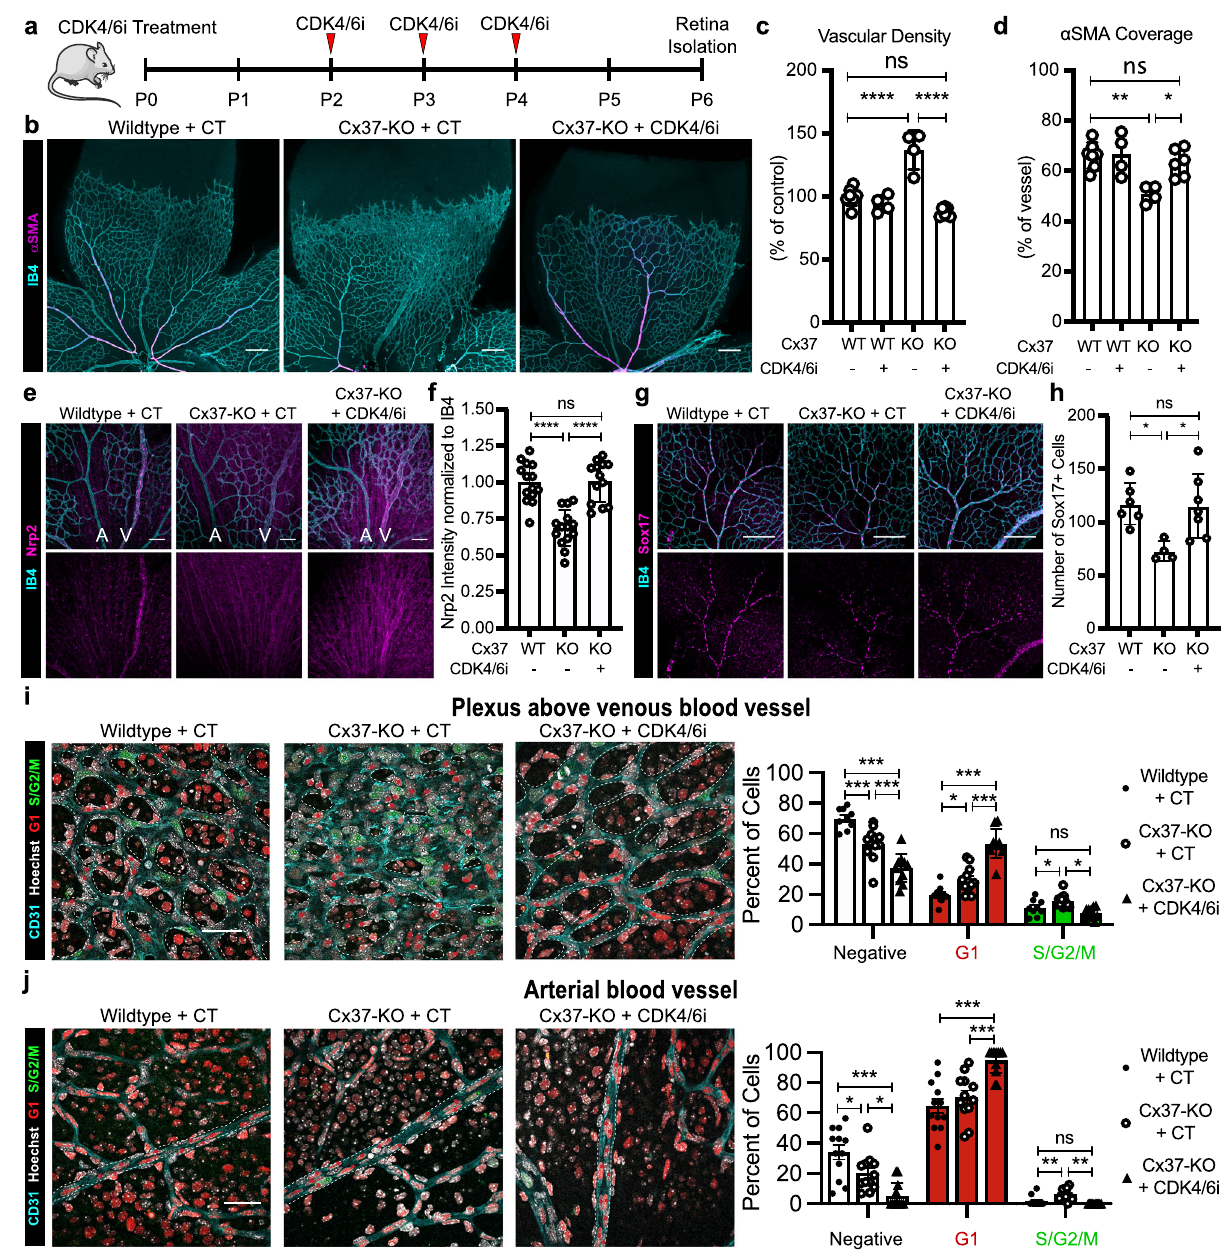
Fig. 7 | Rescue of arterial – venous development defects with pharmacological CDK4/6 inhibition. a CDK4/6i treatment timeline. b Representative confocal images of P6 retinas from WT, Cx37-KO, and Cx37-KO+CDK4/6i treated immu- nostainedwithIB4andanti- α SMA(scalebars=200 μ m),quanti fi edfor: c vascular density (mean+/ − SD), d α SMA vascular coverage (mean+/ − SD). e P6 retinas from WT, Cx37-KO, and Cx37-KO+CDK4/6i treated mice immunostained with anti-Nrp2andIB4(scalebar=150 μ m). f Quanti fi cationofNrp2intensityinretinal veins and arteries normalized to IB4 intensity (mean+/ − SD). g P6 retinas from WT, Cx37-KO, and Cx37-KO+CDK4/6i treated mice immunostained with anti- Sox17 and IB4 (scale bar=150 μ m). h Quanti fi cation of Sox17+ cells in retinal